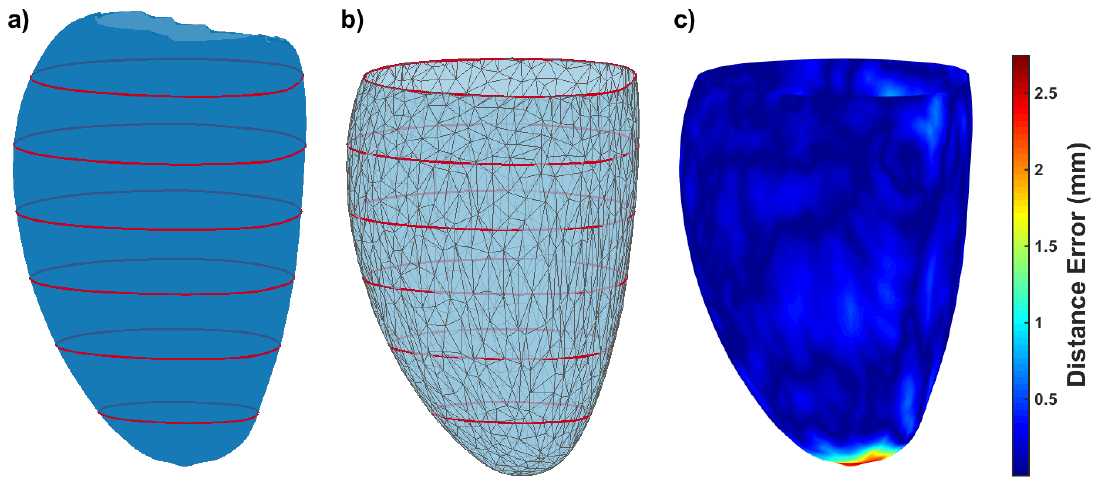
Figure 4. ( a ) the ground truth surface (left epicardium of the mean shape of the SSM) and the synthesized contours in red; ( b ) our resulting mesh given the red contours; ( c ) the surface-to-mesh distance error (in mm). The resulting mesh has been clipped at the level of the most basal contour.